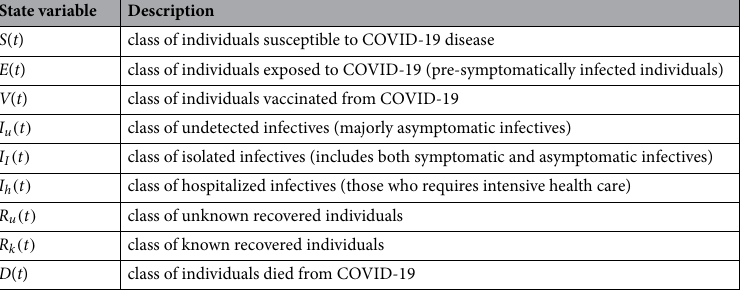
Table 1. The description of COVID-19 model state